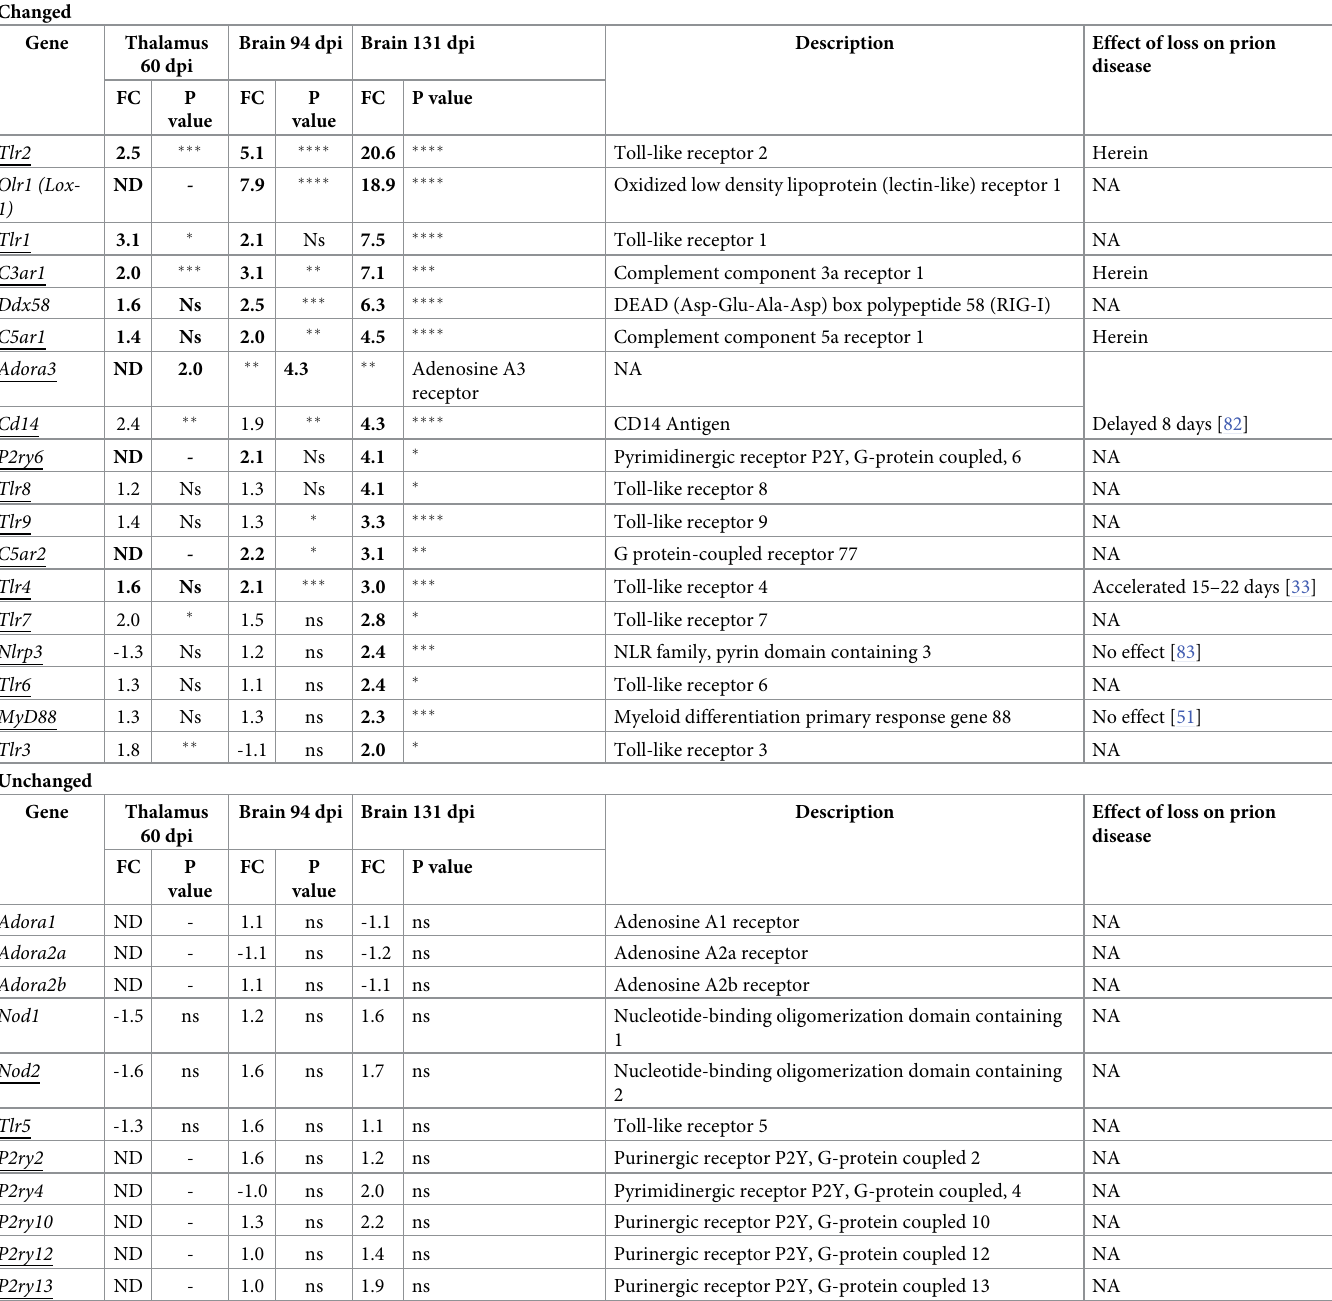
Table 2. Screen for temporal changes in gene expression of damage-associated molecular pattern (DAMP) recognition receptors and associated proteins during infection with scrapie strain 22L. Changed Gene Thalamus Brain 94 dpi Brain 131 dpi Description Effect of loss on prion 60 dpi